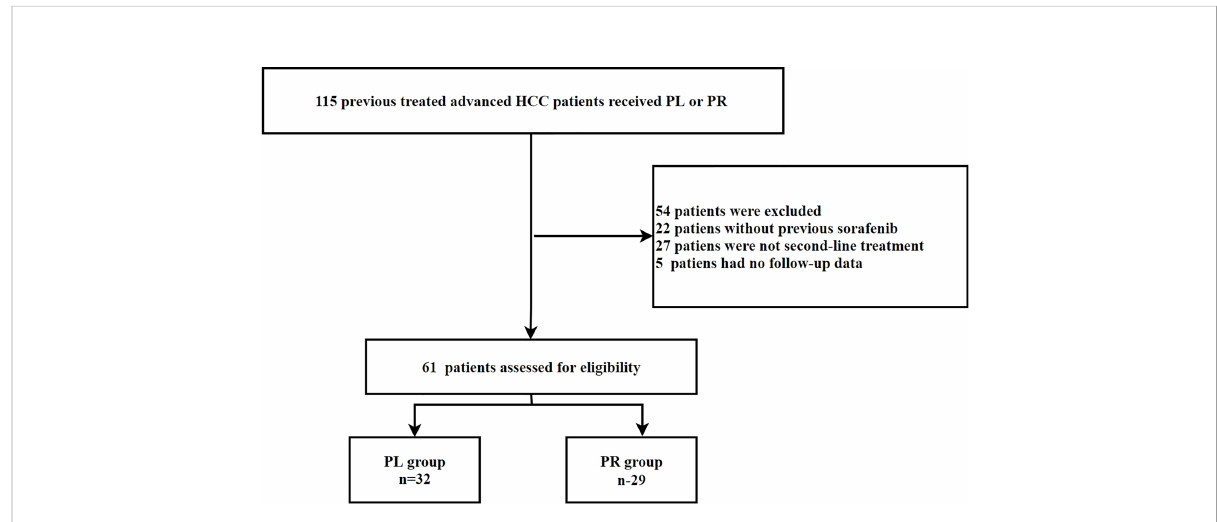
FIGURE 1 Flow chart of patient